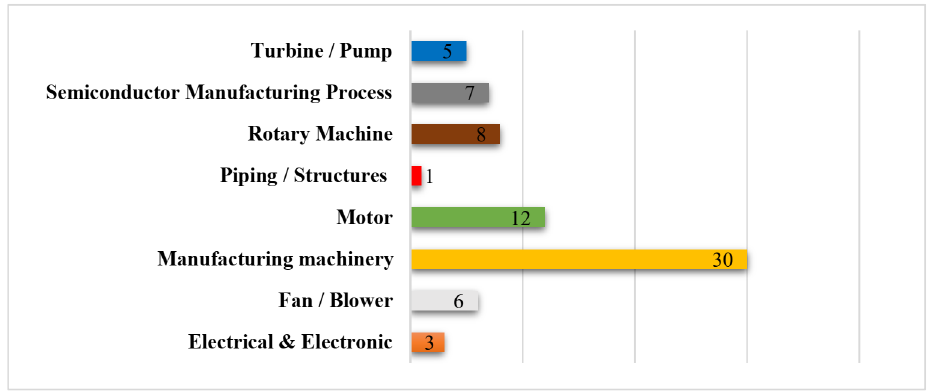
Figure 13. Number of publications for each case study.